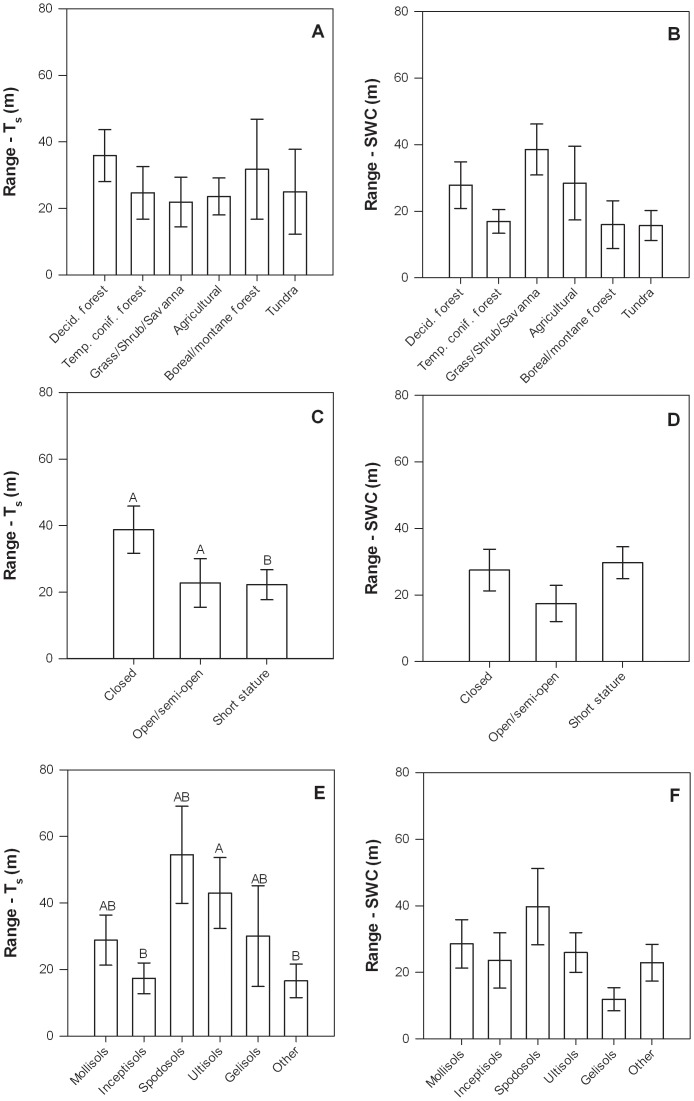
Semivariogram range for Ts (left column) and SWC (right column) at each site in relation to ecosystem type (a, b), canopy structure (c, d), and soil type (e, f).Error bars represent ±1 SE. Bars with different letter were significantly different (p<0.05) based on Tukey HSD tests. The letter “A” corresponds to the largest least square mean(s) and subsequent letters (B, C, …) correspond to progressively smaller least square means.